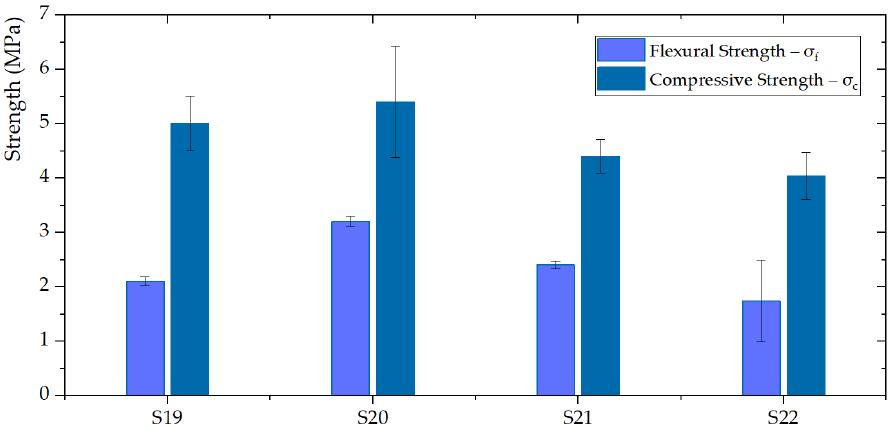
Figure 6. Compressive and flexural strengths of the GFs: S20 has been identified as the best per- forming geopolymer in terms of mechanical parameters.